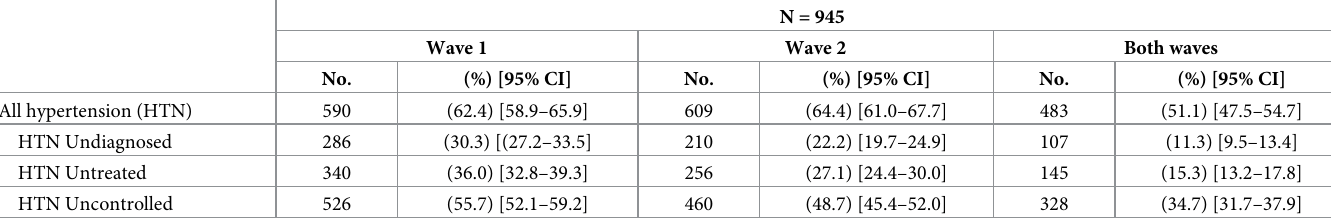
Table 3. Prevalence of hypertension and undiagnosed, untreated, and uncontrolled hypertension.